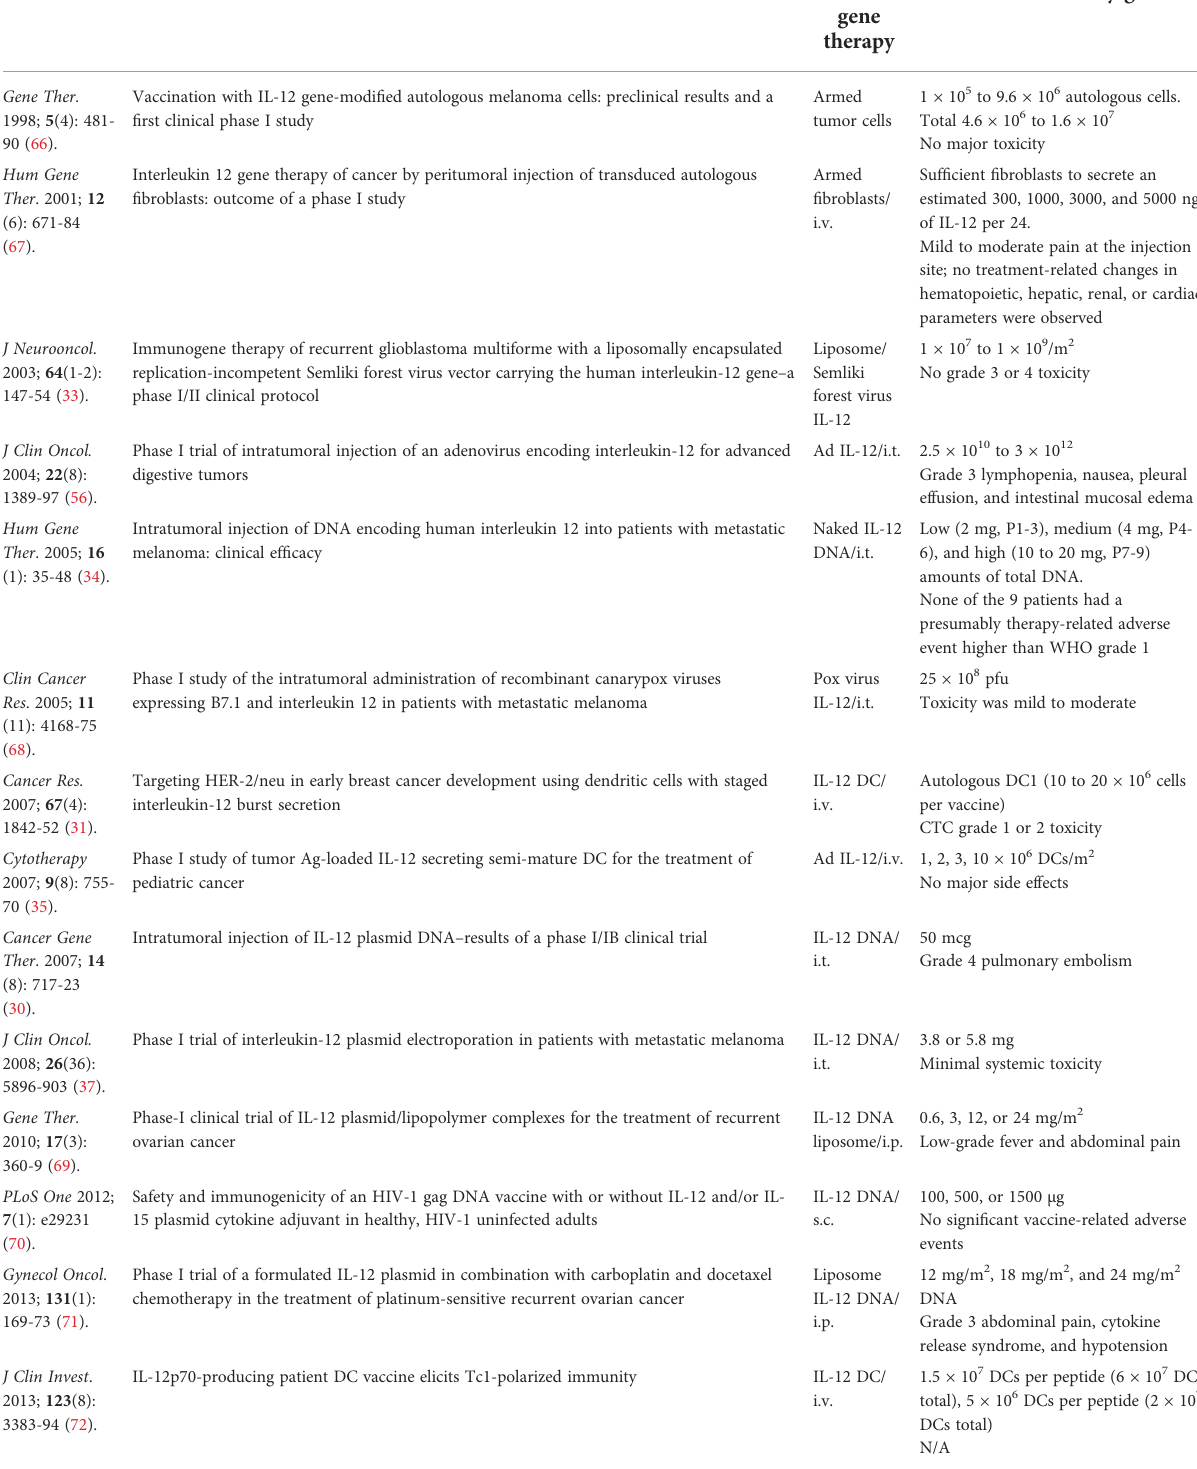
TABLE 2 Summary of human clinical trials of IL-12 gene